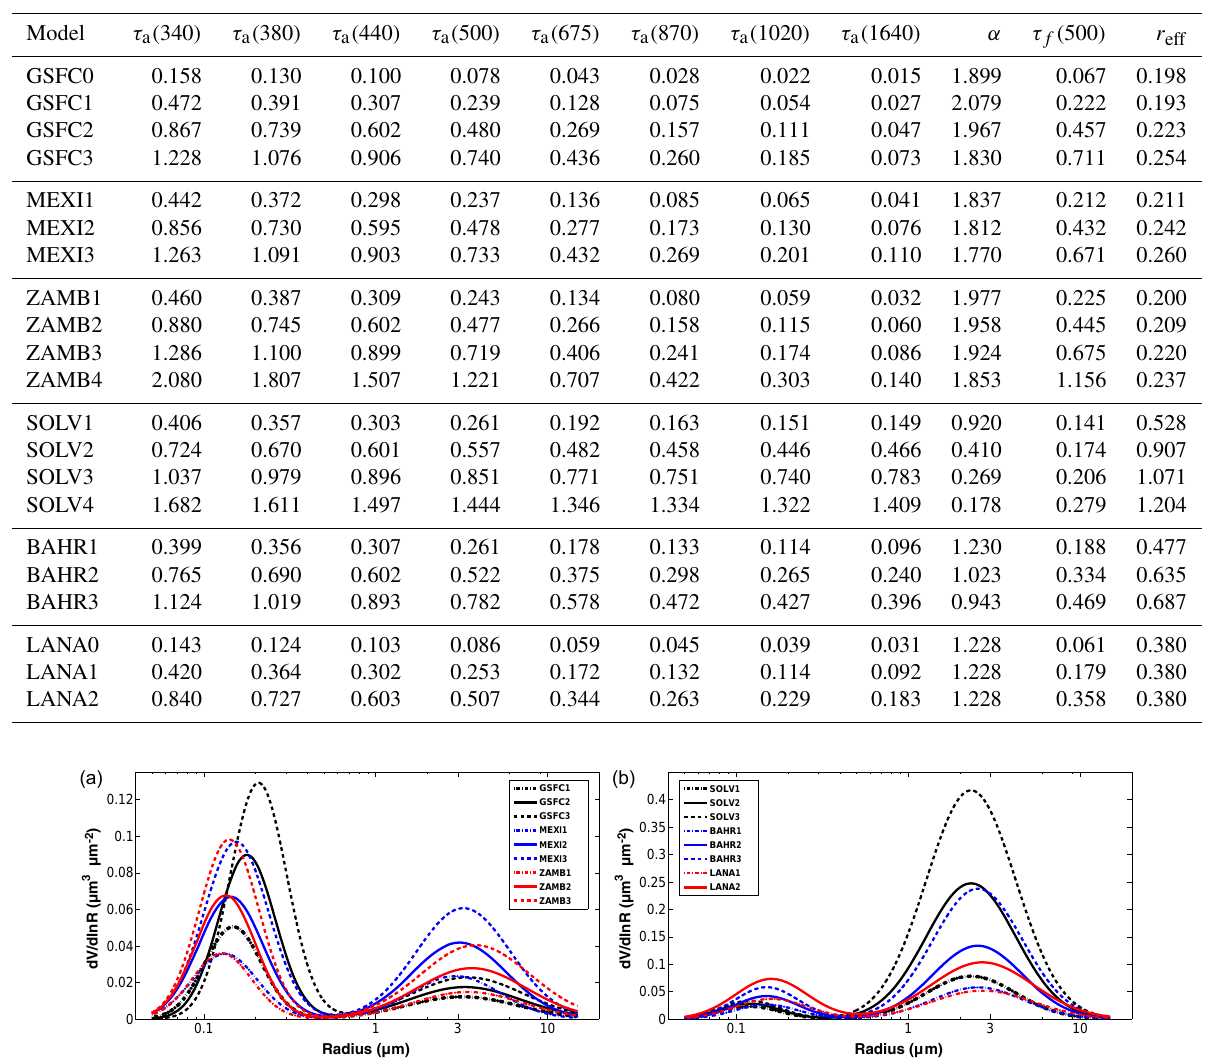
Figure 1. Representation of the aerosol size distributions used as examples in the simulation analysis (described in Table 1). Aerosol models with a predominance of the fine mode are plotted on the left (a) : GSFC (black lines), MEXI (blue lines) and ZAMB (red lines). The rest of the cases are plotted on the right (b) : SOLV (black lines), BAHR (blue lines) and LANA (red lines). In both subfigures the cases with τ a ( 440 ) = 0 . 3 (index 1) are represented by dashed-dotted line, the cases with τ a ( 440 ) = 0 . 6 (index 2) by solid line, and cases with τ a ( 440 ) = 0 . 9 (index 3) by dashed